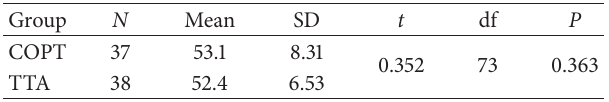
Table 5: Independent-samples 𝑡 -test on critical thinking skills post-